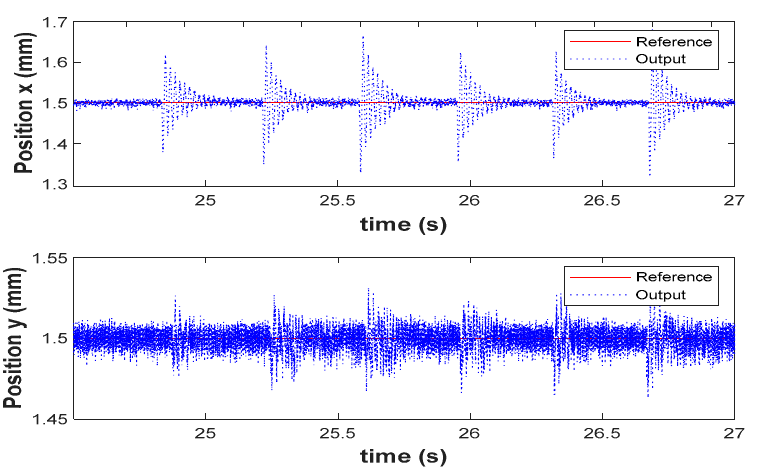
Figure 12. Disturbance rejection capability of 2-DOF AMB, when external disturbances are ap- plied.